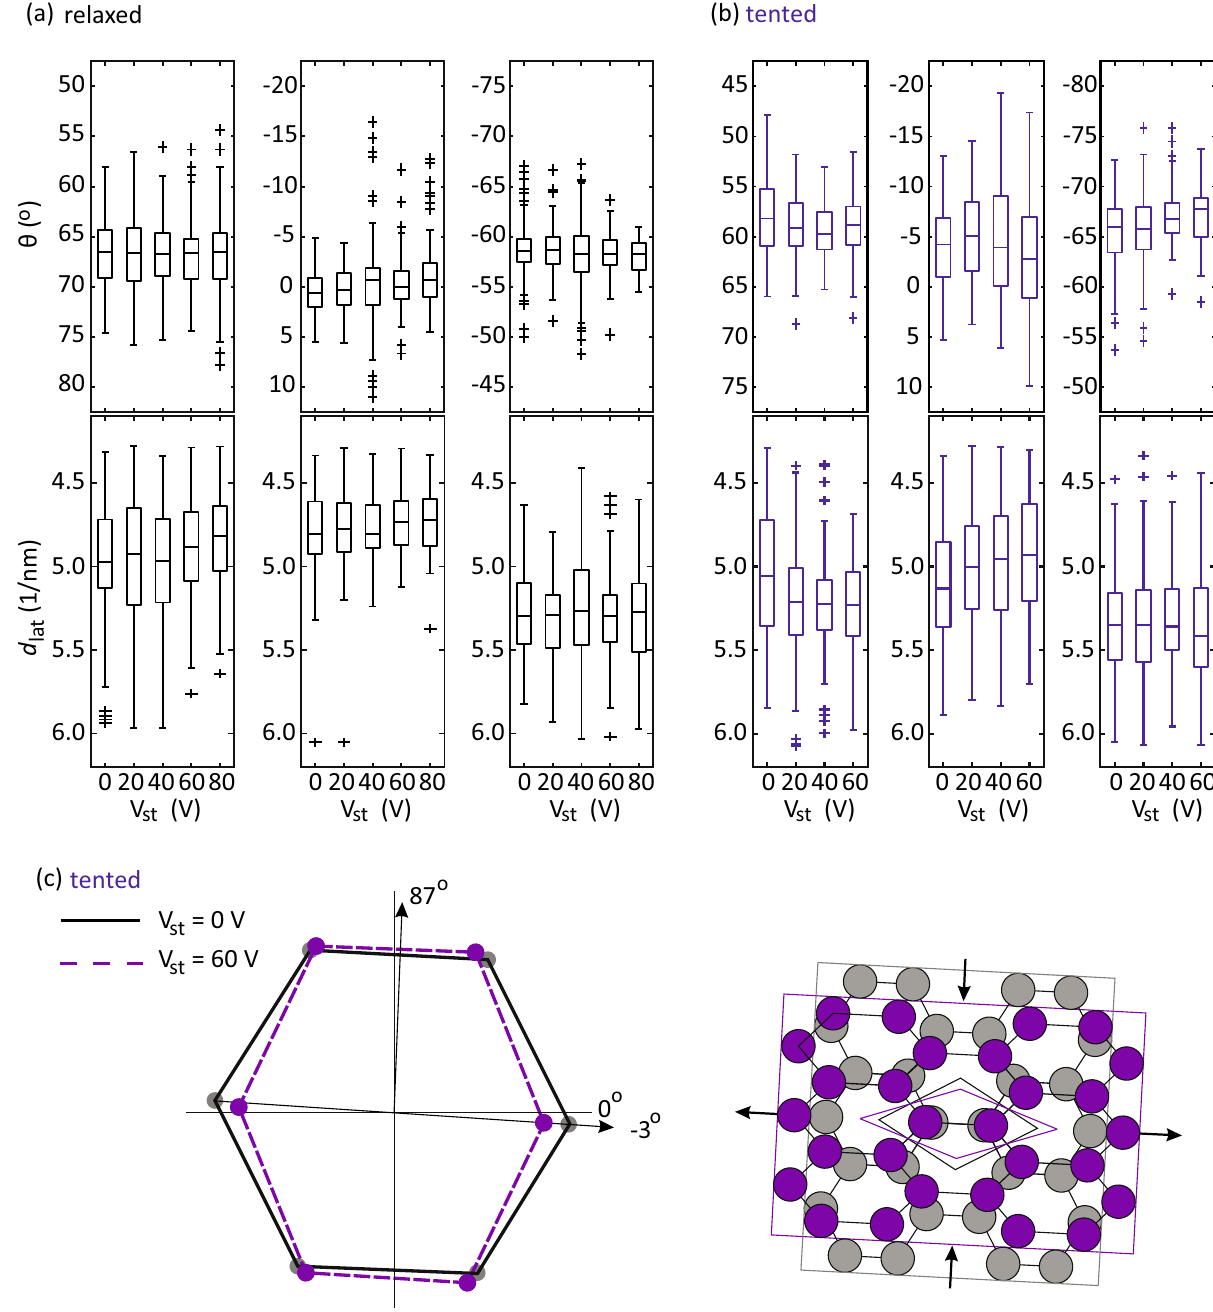
Figure 7. Characterization of strain-controllability. The boxplots of local graphene lattice points in ( a ) relaxed and ( b ) tented cases with increasing piezoelectric actuator voltage (V st ). For each lattice point, d lat is the